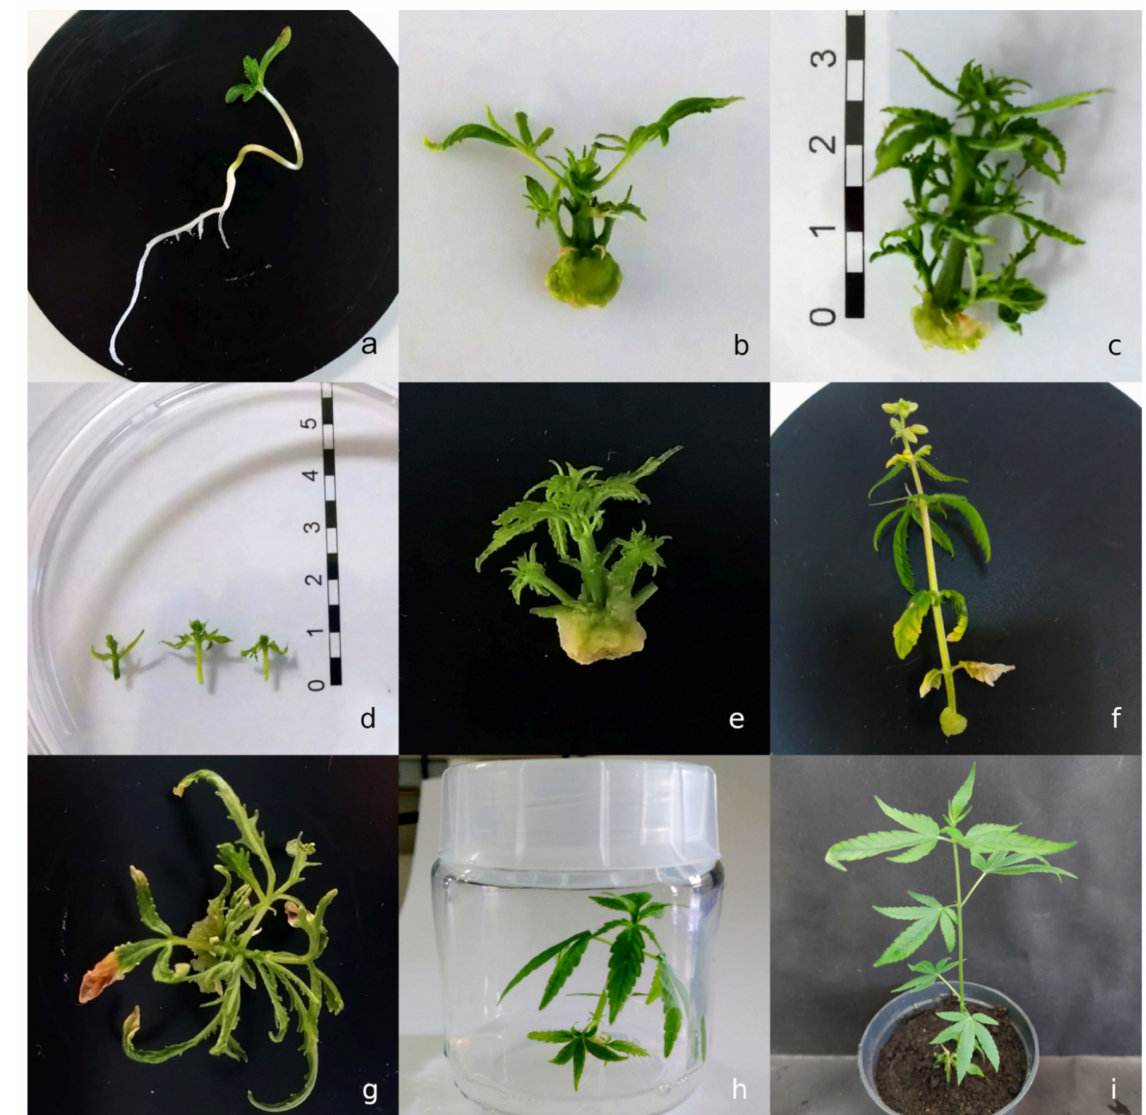
Figure 1. ( a ) Hemp seedling (Fedora 17 var.); ( b ) shoot regeneration (Diana var.) on medium with TDZ and TIBA (5.0 mg L − 1 ); ( c ) shoot regeneration (Finola var.) on medium with TDZ and TIBA (1.0 mg L − 1 ); ( d ) the regenerated shoots (var. Finola); ( e ) shoot regeneration (Fedora var.) on medium TDZ with NPA (2.5 mg L − 1 ); ( f ) flowering Finola explant on medium with mT and NPA (10 mg L − 1 ); ( g ) adverse morphological changes after exposition exposure to high TIBA concentration 12.5 mg L − 1 ); ( h ) regenerated and rooted plant (Fedora var.); ( i ) the acclimatized